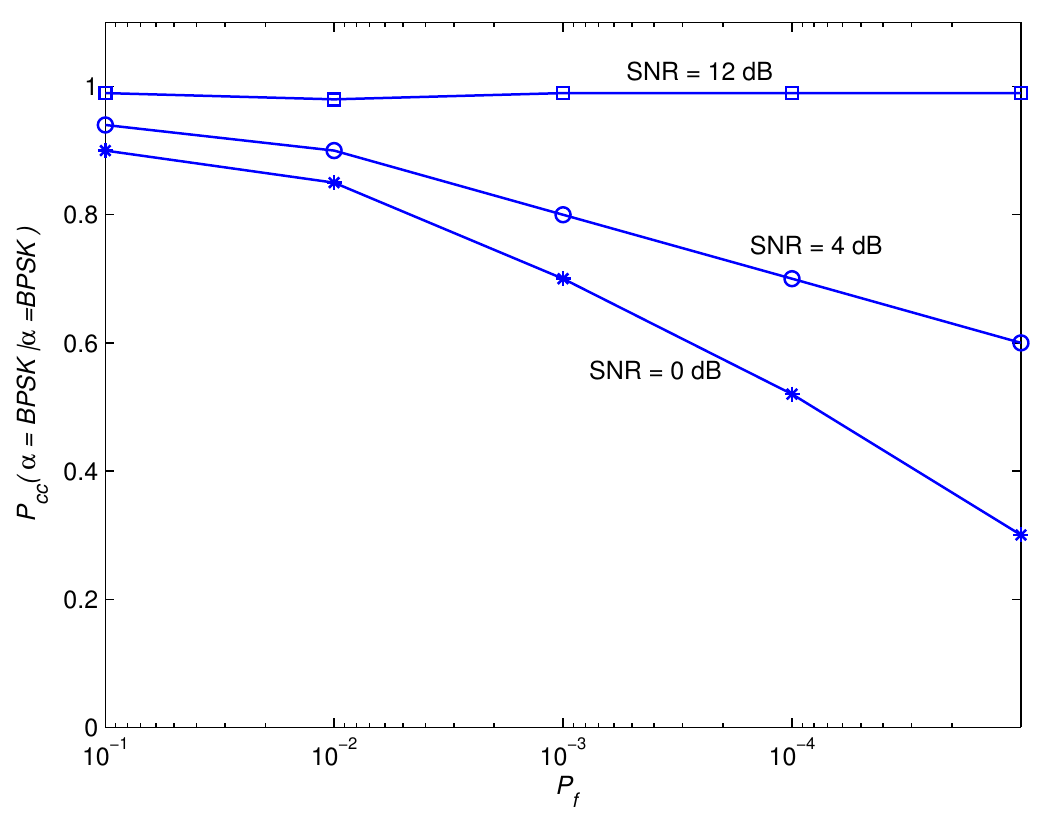
Figure 11. Pcc ( α = BPSK | α = BPSK ) for the modulation group of θ 1